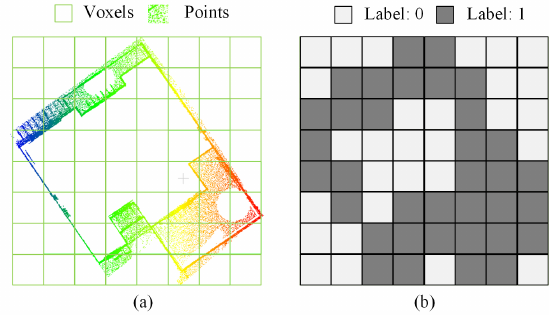
Figure 2. A 2D illustration of voxelization and binarization.